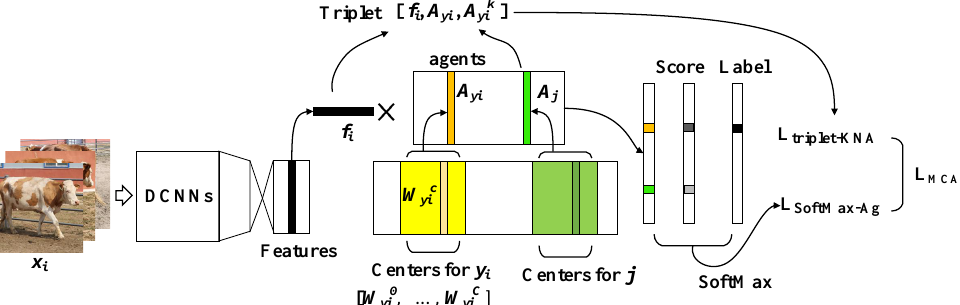
Figure 4. Procedures of multi-center agent loss. Multi-center agent loss includes SoftMax with multiple centers and K -NNAT loss. SoftMax with multiple centers uses the logit score of the agent to calculate the cross-entropy loss and learns the agent for each class. K -NNAT consists of the feature and its corresponding/positive agent and the K -nearest negative agents as hard negatives. Then, the model is jointly supervised by multi-center agent loss to learn more center points for features to concentrate on and meanwhile enforces separation among agents of different classes. Best viewed in